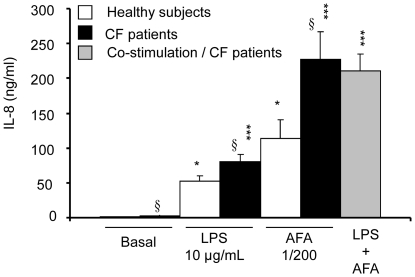

Pseudomonas aeruginosa and Aspergillus fumigatus antigens stimulation of IL-8 production.
Pseudomonas aeruginosa (LPS, 10 µg/mL) and/or Aspergillus fumigatus (AFA, 1/200) antigens were added in the whole blood from 4 to 10 healthy subjects (open bars) and 23 CF patients (solid bars and grey bar for co-stimulation) for 24 h. After incubation, IL-8 release (ng/mL) was measured by ELISA. Data are shown as mean ± SEM. Mann and Whitney test: *P<0.05, *** P<0.0001 vs basal; § P<0.05 vs healthy patients.